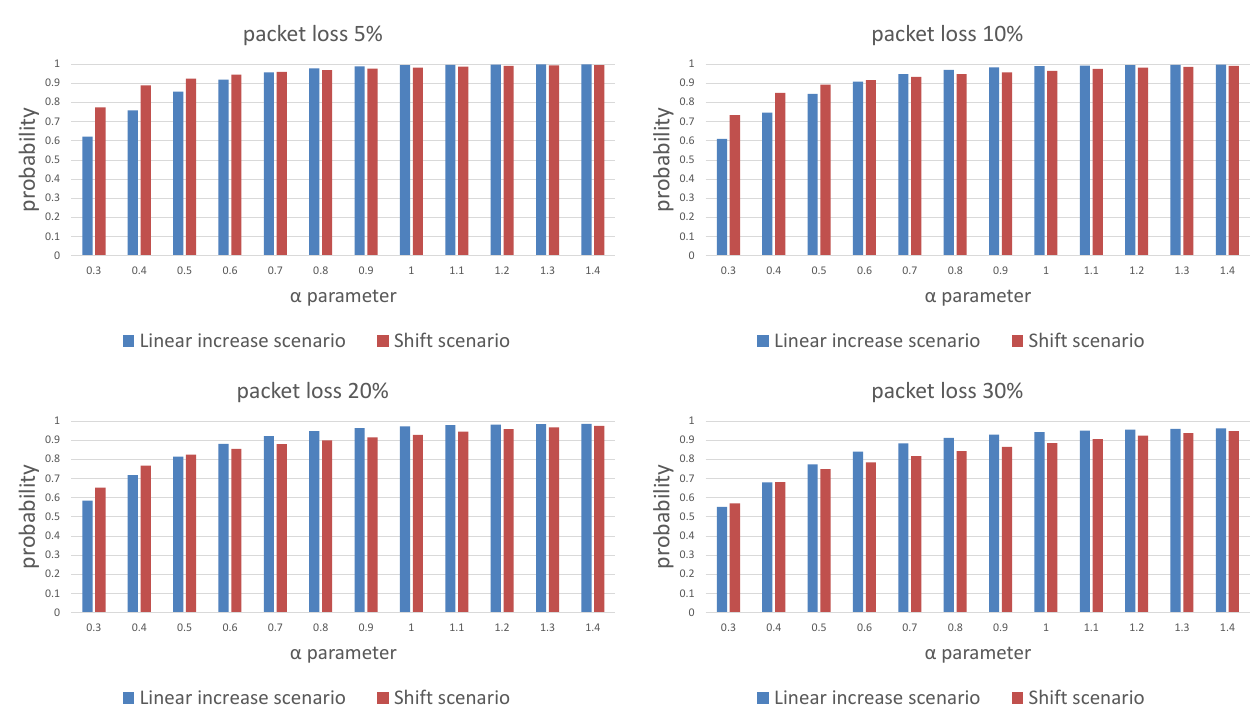
Figure 7. Comparison of the message reception probability over three trials for different packet loss probability for the linear window size increase and window shift algorithms.